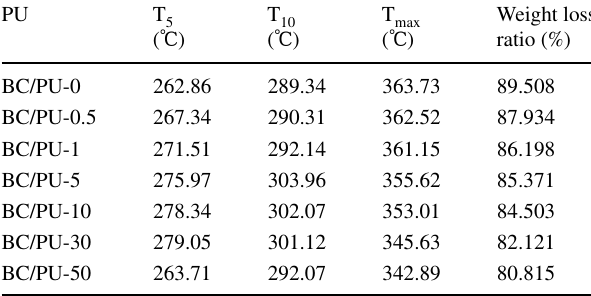
Table 1 The thermal weightlessness of BC/PU foam